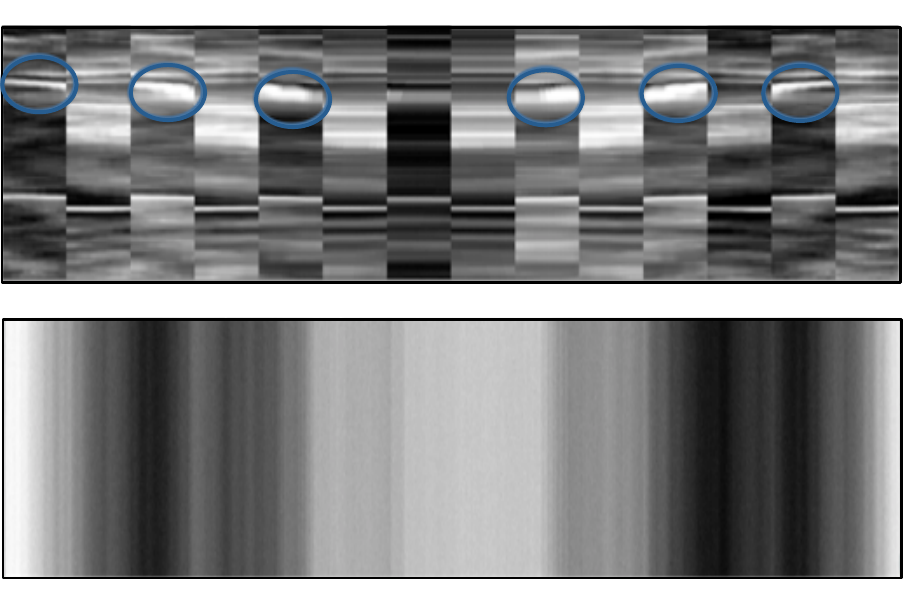
Figure 11. Top frame shows the resulting side slither data (after a horizontal correction has been applied) when imaging over the Libya 4 simulated landscape with all 14 arrays of OLI. The bottom frame shows the result of applying a side slither correction to a flat plate of sand with the relative gains obtained from the top frame. The blue circles highlight the smearing effect caused by arrays that are not oriented at 90 degrees when in side slither